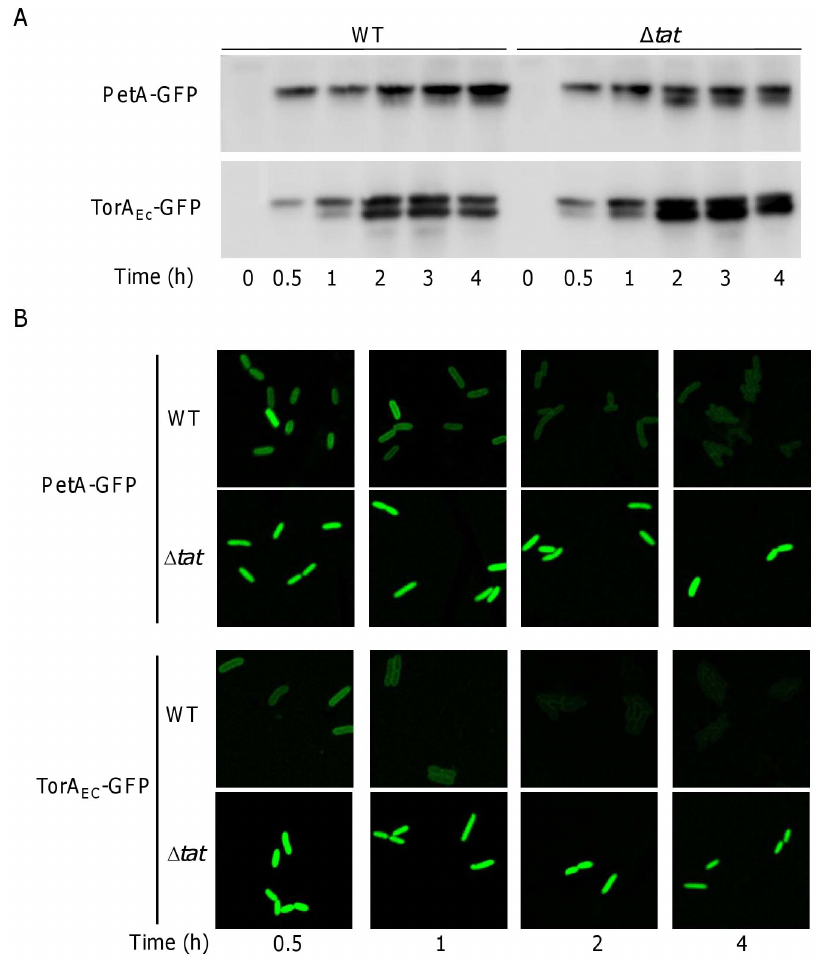
Figure 6. Cleavage of Tat signal peptide of PetA is independent of Tat-mediated translocation. Cells at exponential phase ( , 0.4 of OD 600 ) were induced by 0.1 mM IPTG for 2 hours, and then sampled for subsequently analysis. A. Time course Western blotting of GFP fusions expressed in the wild type and D tat strains. Same amount of whole cell protein was loaded in each lane. B. Fluorescent images for time course of expression and localization of PetA-GFP and TorA Ec -GFP in the wild type and tat mutants. Refer to Methods for details.